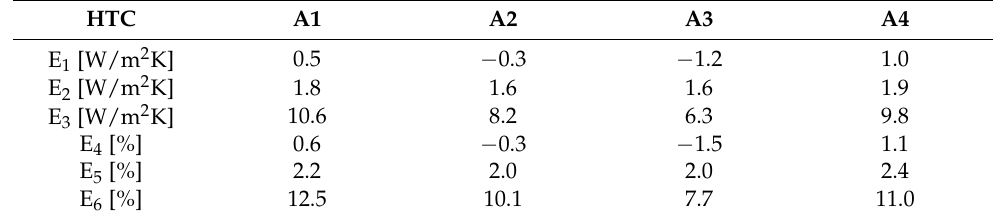
Table 12. Values of estimates E 1 –E 6 for HTC (20)–(25) with heating process p2 in planes A1–A4.